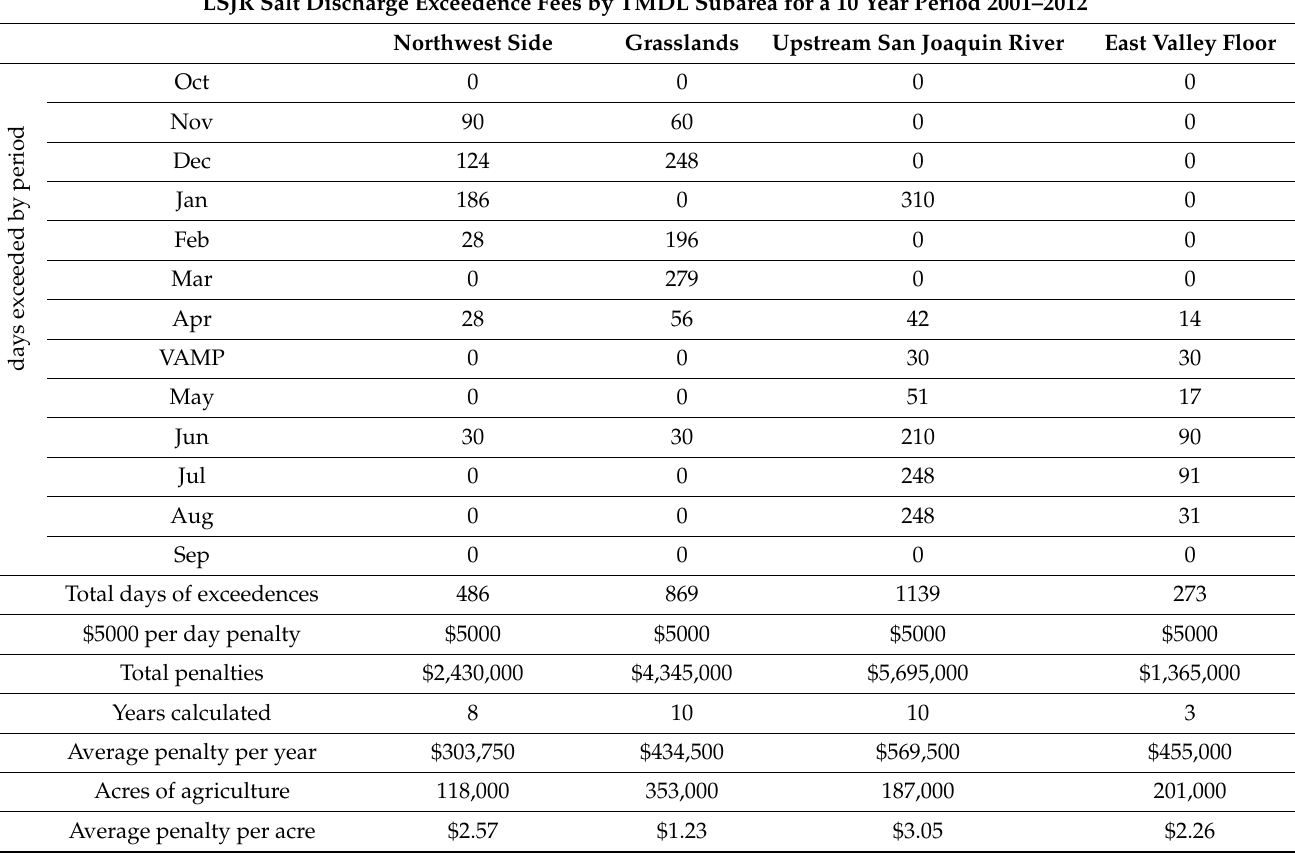
Table 1. Hypothetical SJR daily salt discharge exceedance fees by subarea (10-year period 2001–2012) using an assumed $5000/day fine for exceedance of the 30-day running average mean EC objective